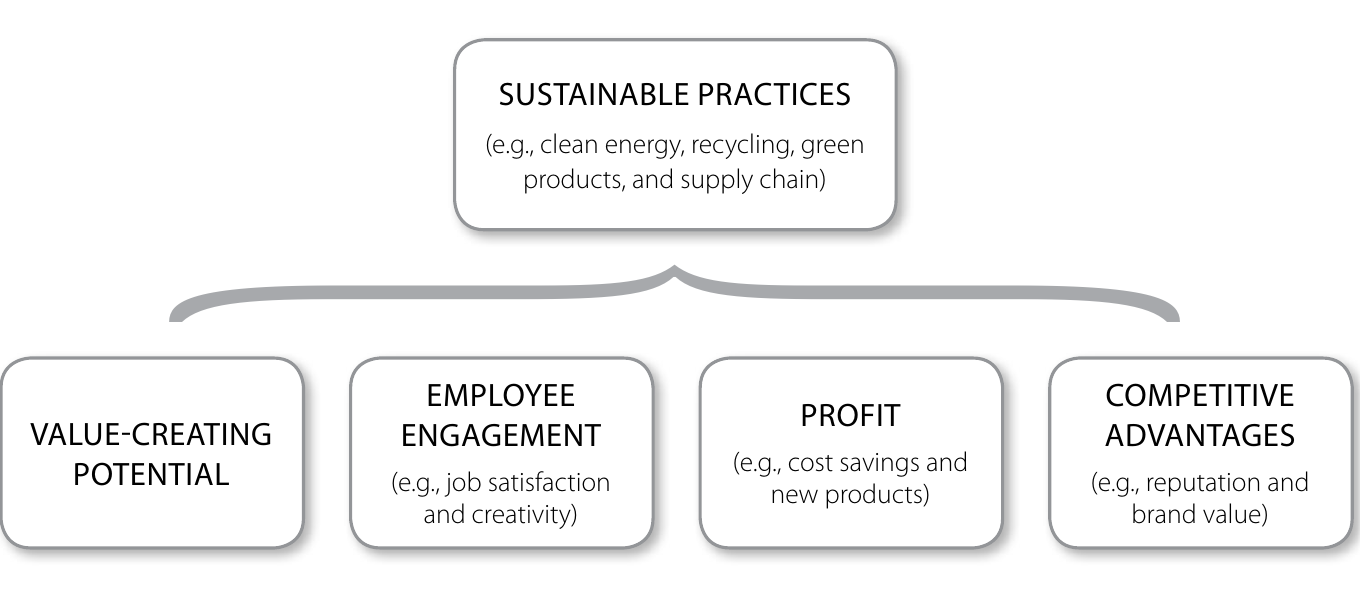
Figure 1. Sustainable practices as behaviors with value-creating potential